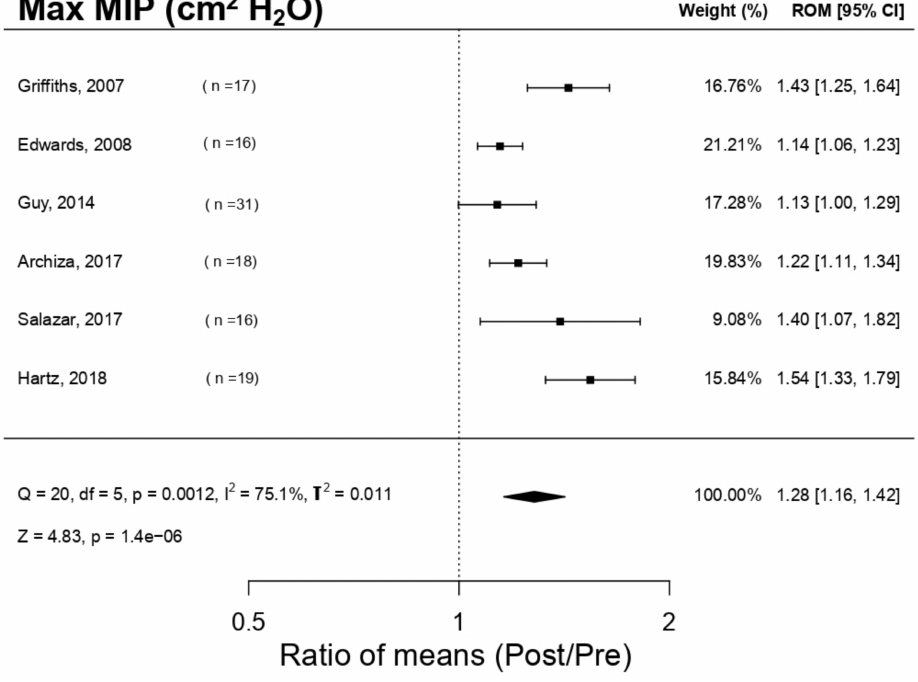
Figure 2. Forest plot of the meta-analysis of the effects of inspiratory muscle training with PowerBreath ® on Peak Inspiratory Pressure. MIP = Peak Inspiratory Pressure; CI = Confidence Interval; ROM = Ratio of Means; Pre = Pre-inspiratory muscle training; Post = Post-inspiratory muscle training; Q = Cochran’s Q statistic; df: degrees of freedom; p = p -value (the first one refers to Cochran’s Q, the second one to Z); I 2 : I-square statistic; T 2 : Tau-squared; Z: Z-value.